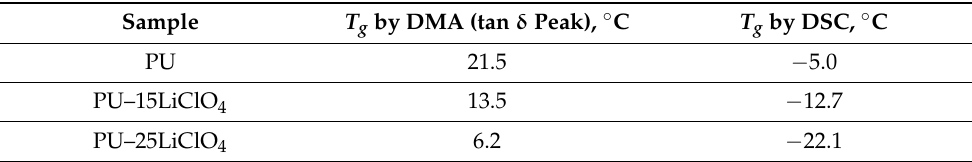
Table 6. T g of PU, PU–15LiClO 4 , and PU–25LiClO 4 recorded by DSC and